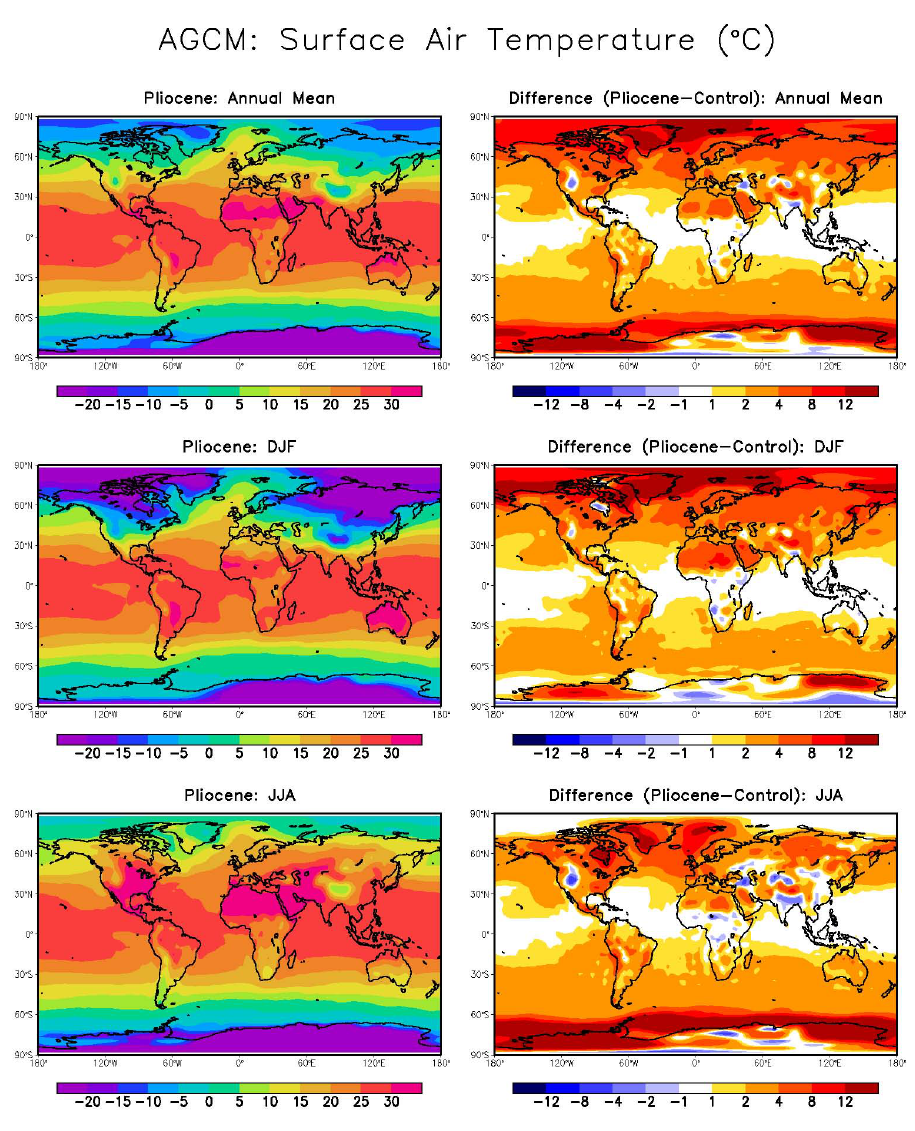
Fig. 9. AGCM mid-Pliocene surface air temperature averaged over the entire year, December-January-February and June-July-August (left side), and the differences between these values and those of the control experiment (right